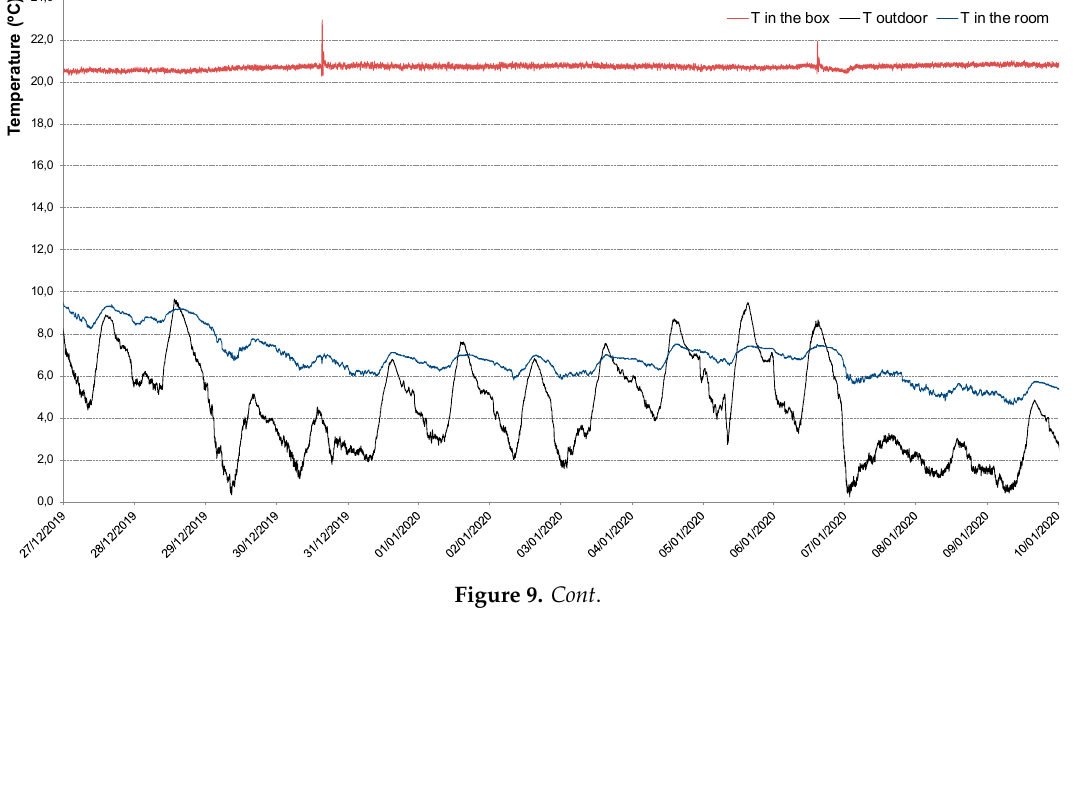
Figure 8. Vertical section of the metering box with the position of the T-RH combined sensors.